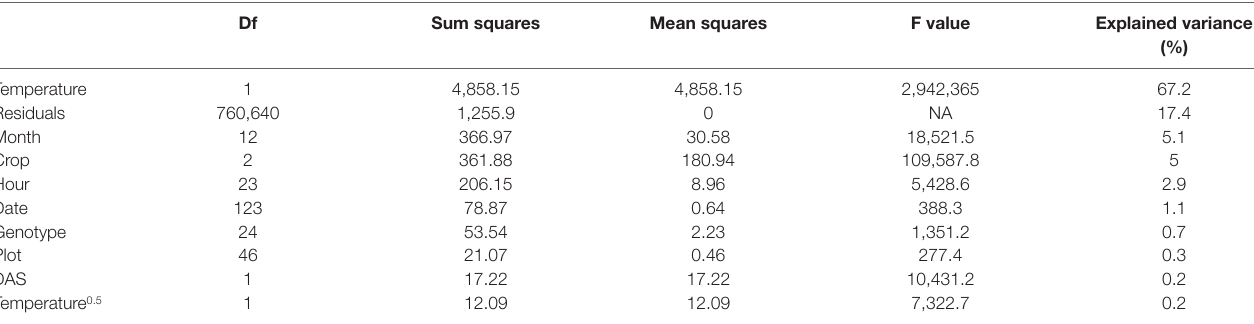
TABlE 1 | Reoxidation efficiency 5 ms after primary quinone (Q A ) reduction (F r2 /F v in the dark and F r2 '/F q ' in the light) measured in four crop species over two seasons in an unheated glasshouse was analyzed using a linear model (n = 760,874 measurements). Depending factors were temperature (including a square root term), time point of the measurement (month, date, and hour), crop species, genotype, plot, and days after sowing (DAS). Descriptors of the linear models are degree of freedom (Df), sum of squares, mean of squares, ratio of mean squares, and mean squares error (F value) and the explained sum of squares per factor (explained variance) in